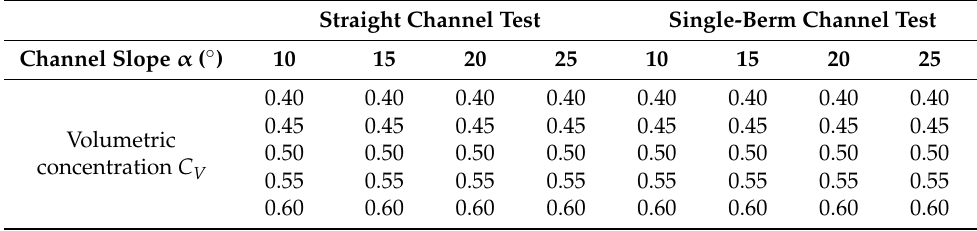
Table 3. Experimental conditions used in this study.